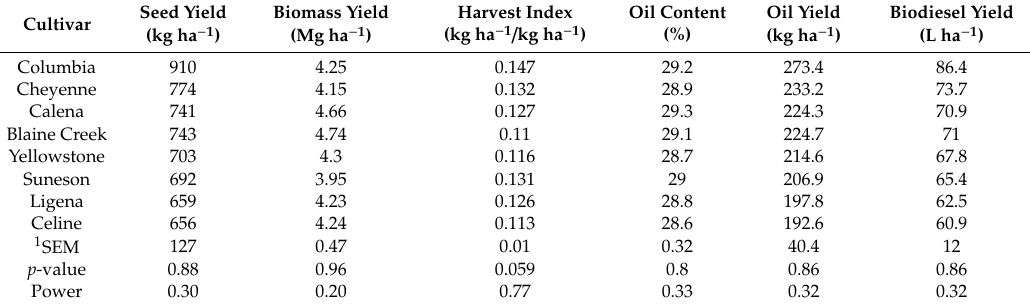
Table 3. The main e ff ect of C. sativa cultivars on seed yield (kg ha − 1 ), biomass yield (Mg ha − 1 ),